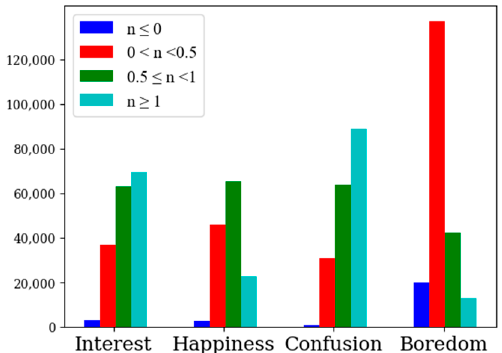
Figure 4. Distribution map of pupil diameter difference in four emotional states.